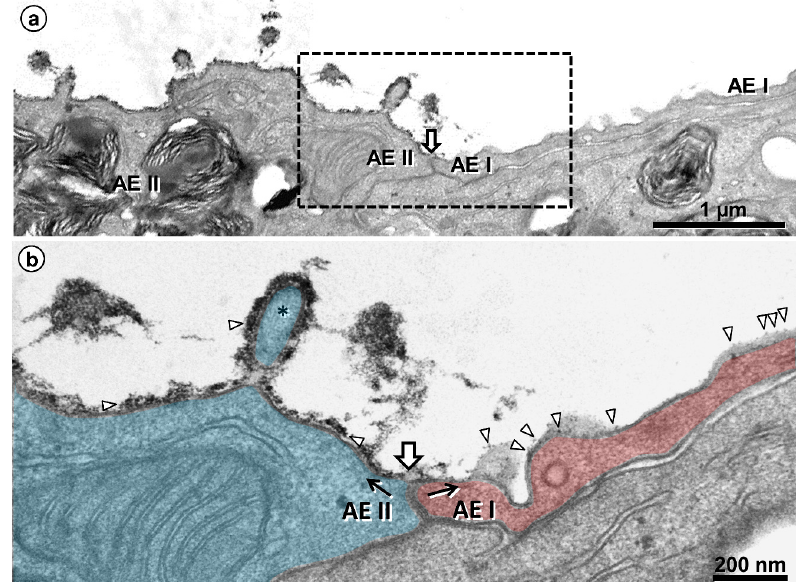
Figure 5. Human lung. Comparison of the glycocalyx of an alveolar epithelial type I (AEI) and type II (AEII) cell. ( a ) Alveolar surface depicted in sequence from an AEII cell (left) across the cell contact (block arrow) to an AEI cell (right). The boxed area is shown in ( b ) at higher magnification. ( b ) Different intensity of glycocalyx on the AEII (left, colored blue) and AEI (right, colored red) cell (along black arrows). The thorium dioxide deposition (marked by arrowheads) is intense on the AEII cell, forming a nearly continuous layer also visible on a microvillus (asterisk), while it appears rather punctual on the AEI cell.